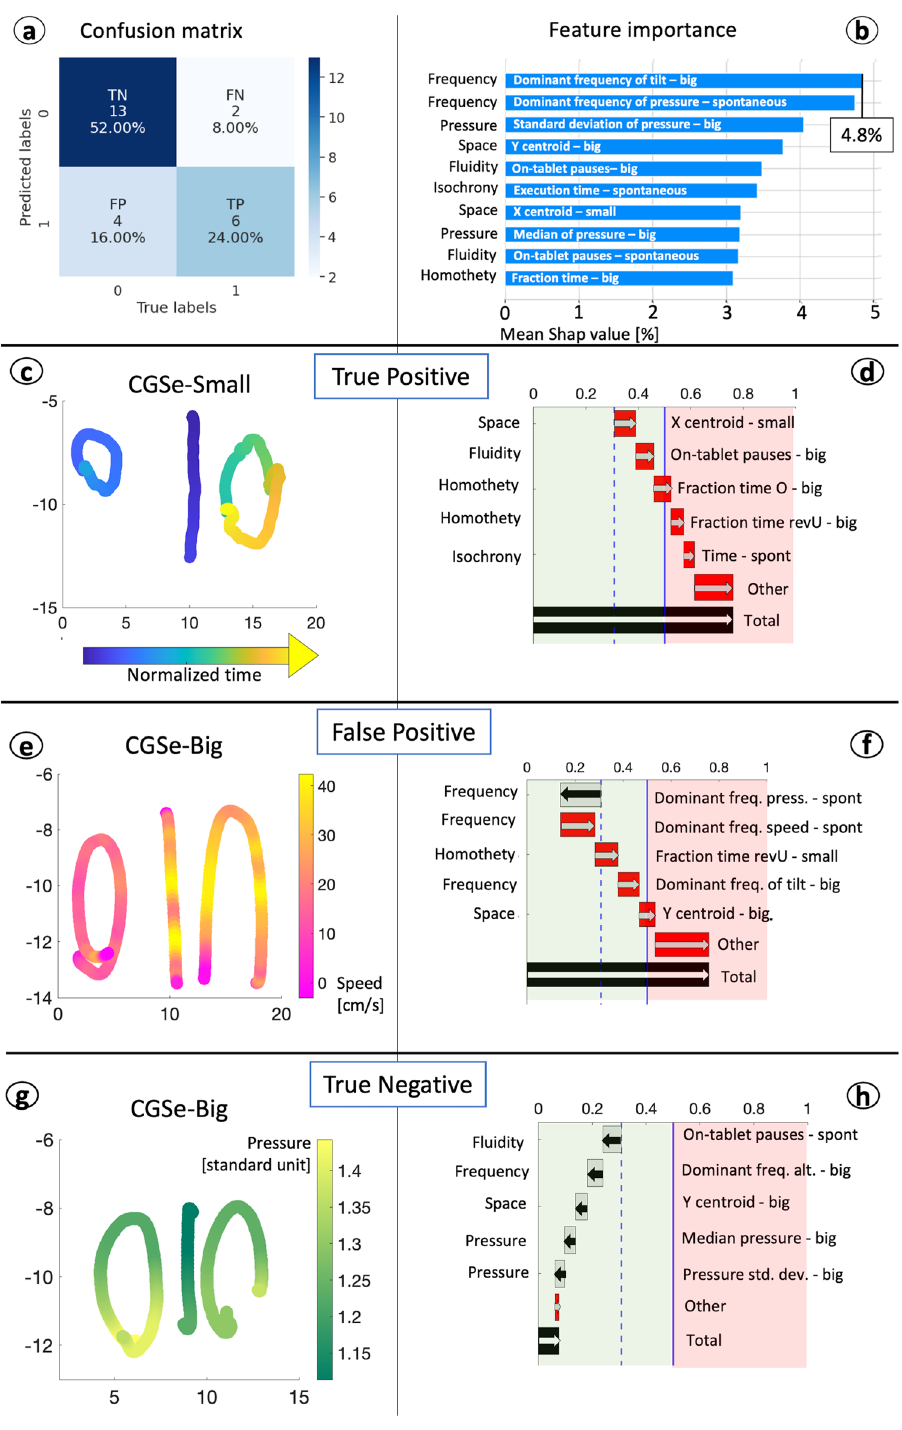
Figure 5. Results of the prediction. ( a ) confusion matrix of test predictions. ( b ) global normalized feature importance for the LearNet predictions on the test set, computed as Shapley values averaged on all subjects. ( c, e, g ) Sample executions. ( d, f, h ) The corresponding feature contribution to the